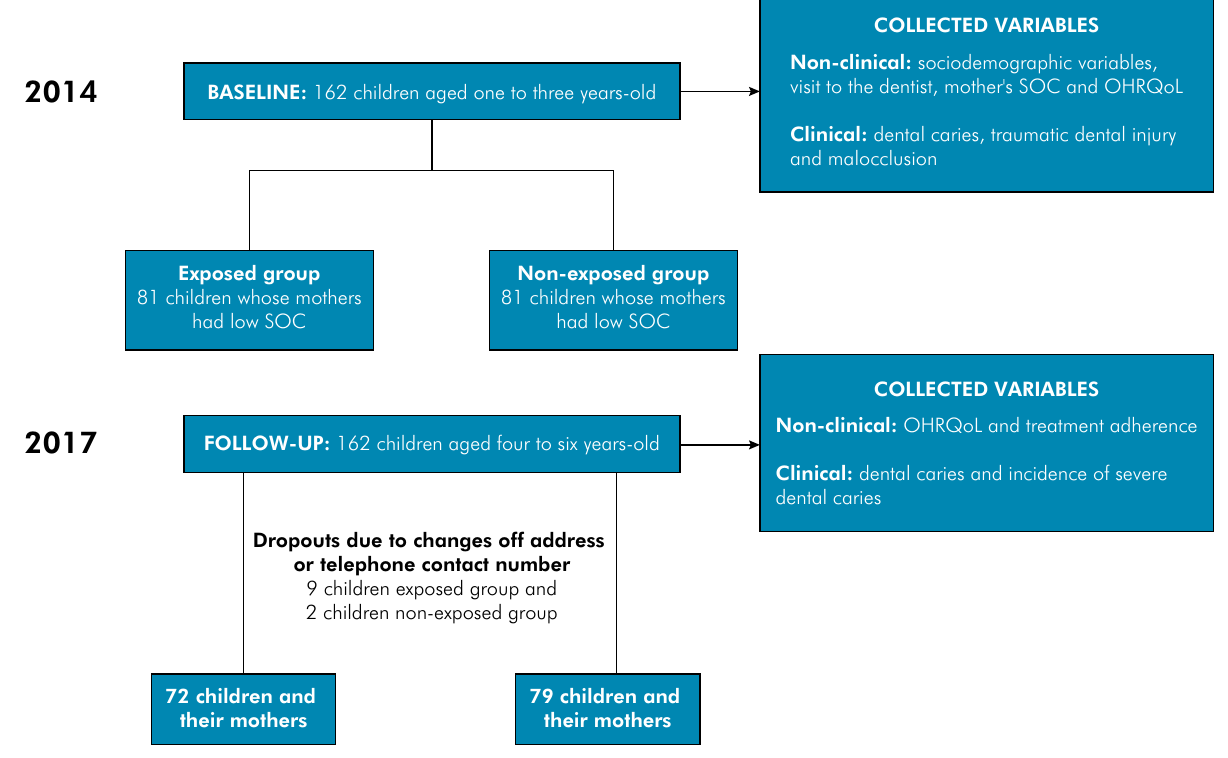
Figure. Description of study steps, sample size, and dropouts after three years of